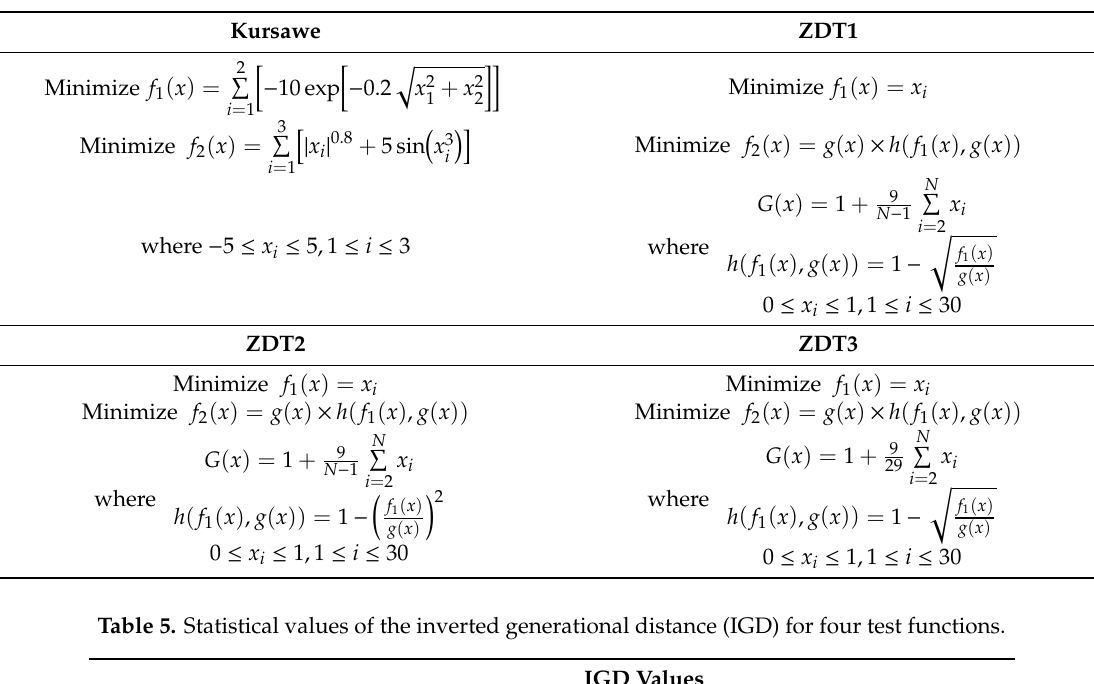
Table 4. Four test benchmark functions.